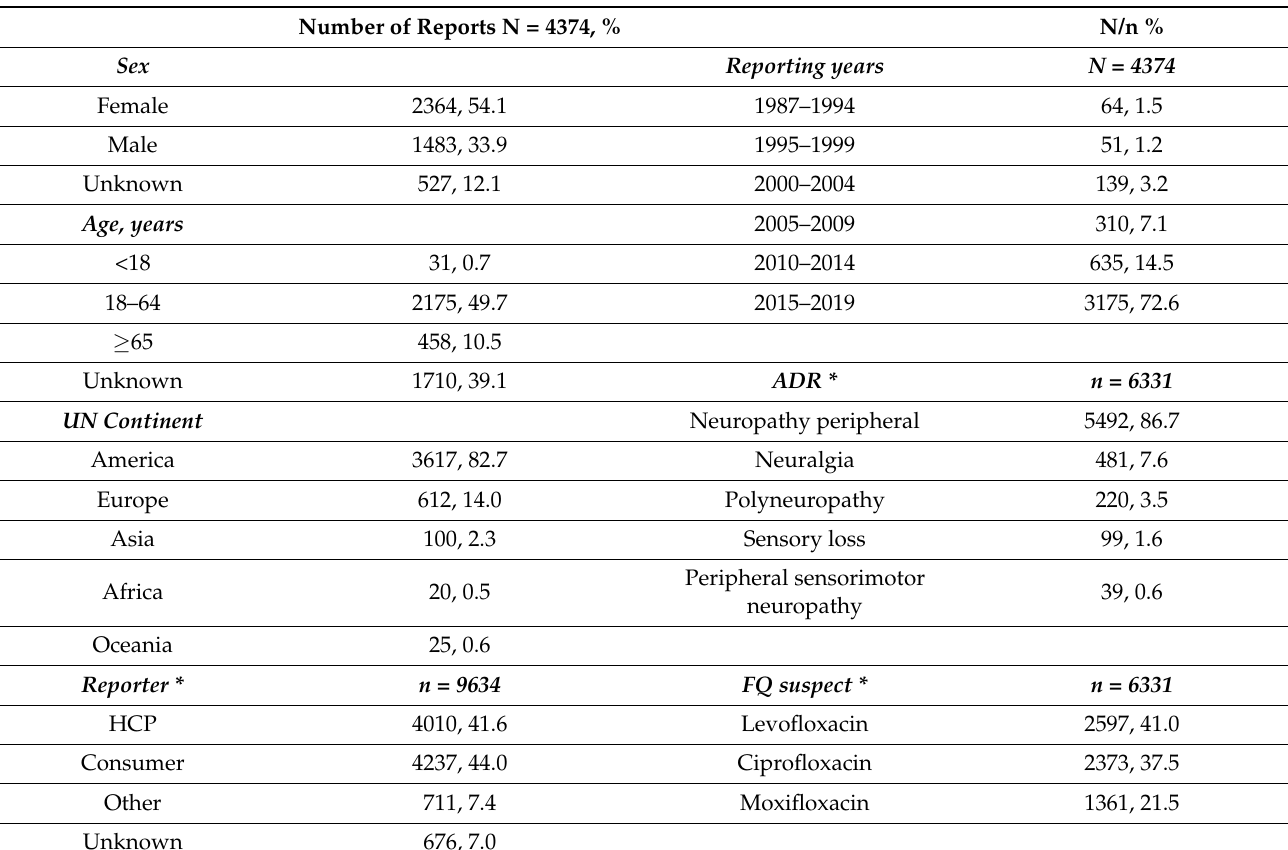
Table 2. General characteristics of reports.